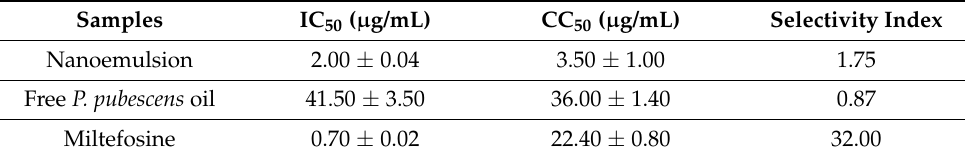
Table 3. Leishmanicidal activity (IC 50 ) , cytotoxicity (CC 50 ) and selectivity index.